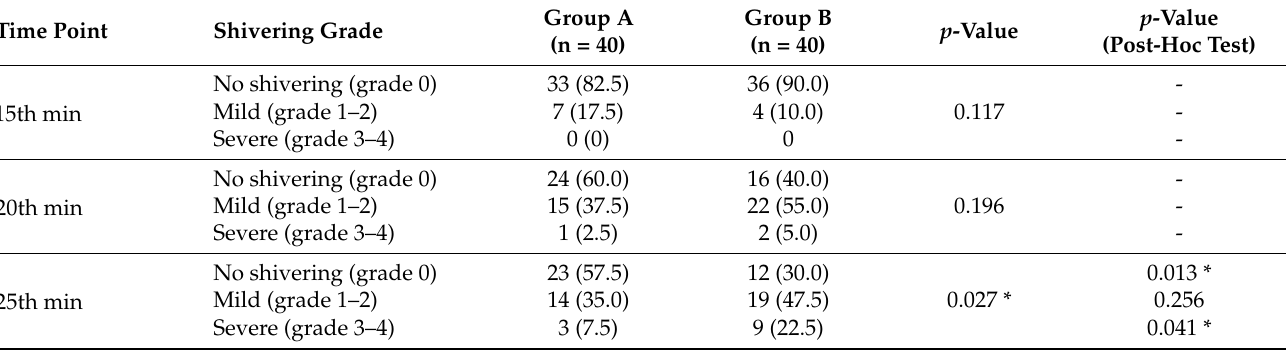
Table 3. Shivering grade at every time